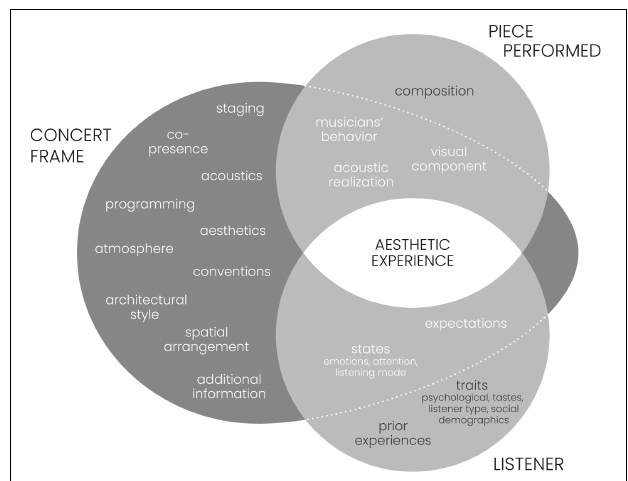
FIGURE 2 | Expanded frame-music-listener model to show potential concrete mediating and moderating effects of concert components on the performance and the listener and thus, the aesthetic experience of